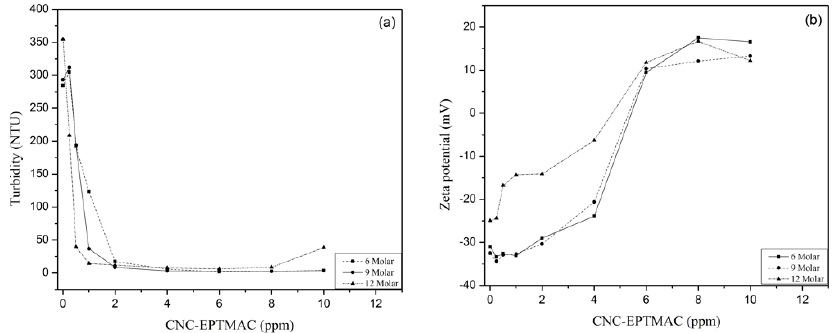
Figure 9. Effect of molar ratio on flocculation of SiO 2 in the present of CNC-EPTMAC. ( a ) Turbidity and ( b ) Zeta potential change.